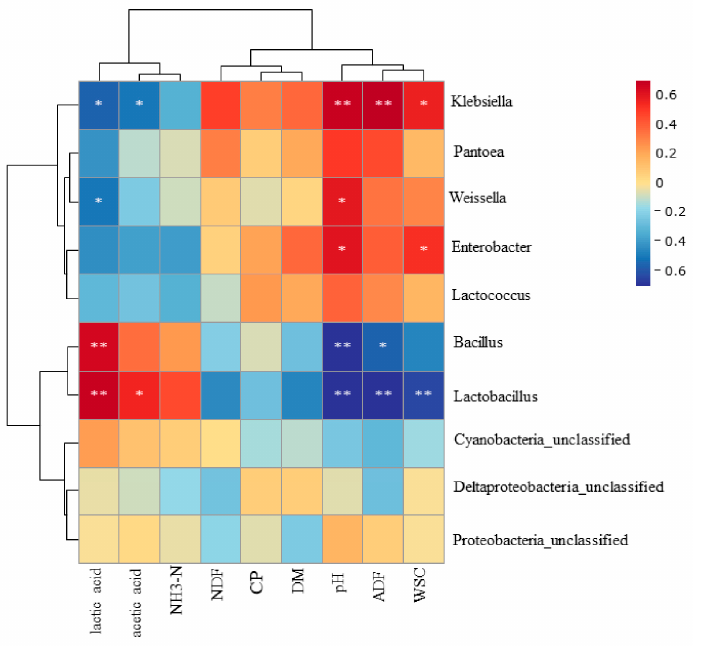
Figure 4. Heatmaps of Pearson’s correlations between the dominant genera, chemical compositions and fermentation quality. Red represents a positive correlation, while blue represents a negative correlation. Levels of significance are shown as follows: * p < 0.05; ** p < 0.01. NH3-N, ammonia nitrogen; NDF, neutral detergent fiber; CP, crude protein; DM, dry matter; ADF, acid detergent fiber; WSC, water-soluble carbohydrates.